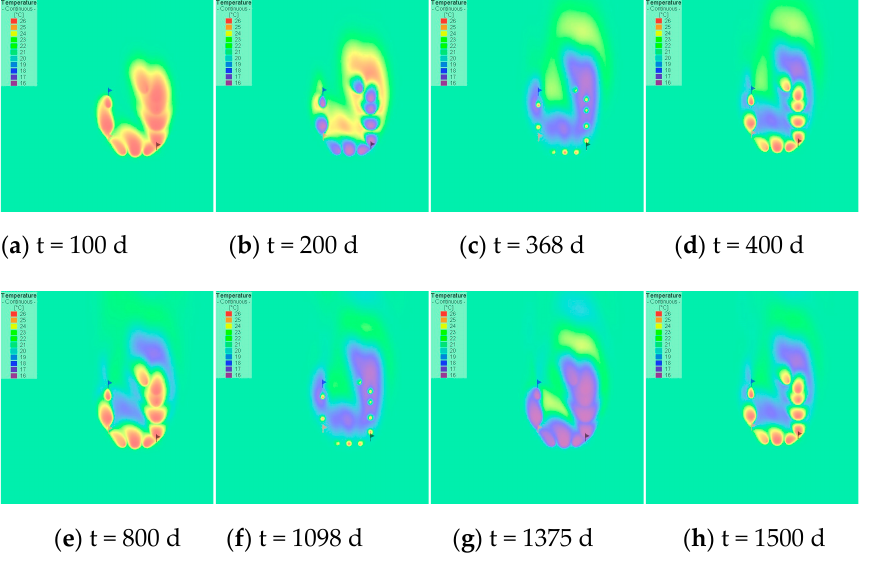
Figure 5. Temperature distributions of main model area in five cooling and heating periods. Note: ( a , c , e , g ) were in the cooling period, while ( b , d , f , h ) were in the heating period.